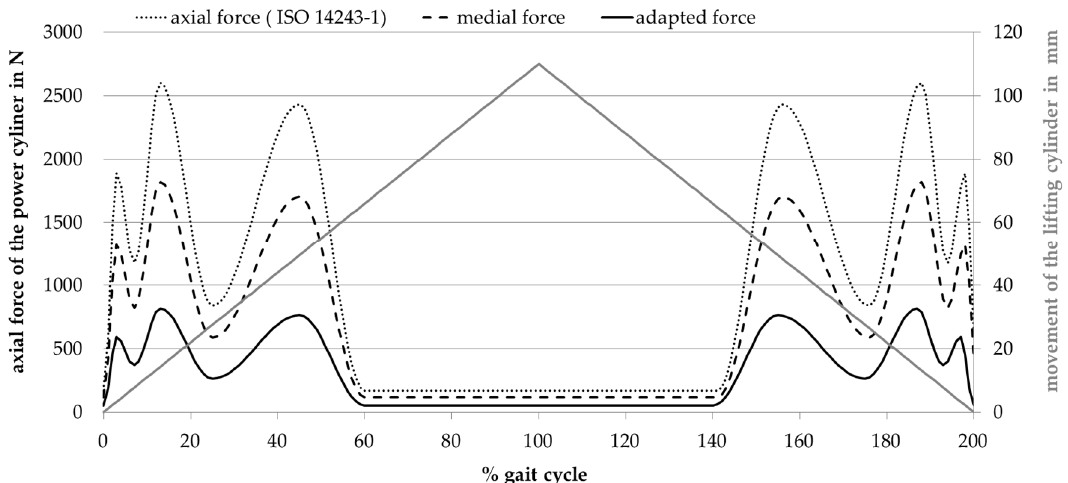
Figure 5. Adapted load curve in the rolling-sliding test bench and corresponding movement of the lifting